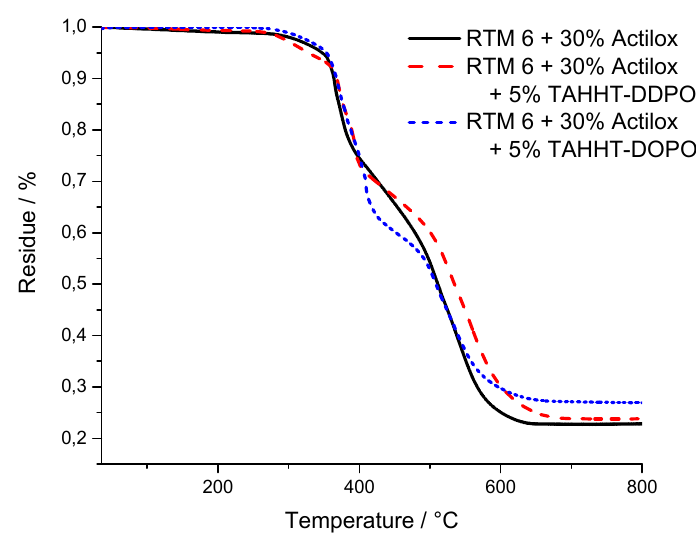
Figure 13. TG curves of Disperal-containing samples measured under N 2 -atmosphere.